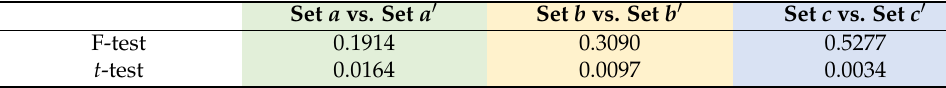
Figure 4. Bitcoin dependability before and after application of the DDAA under sets c and c ′ . Table 3. The p -value in F-test and t -test. Set a vs. Set a (cid:48) Set b vs. Set b (cid:48) Set c vs. Set c (cid:48)